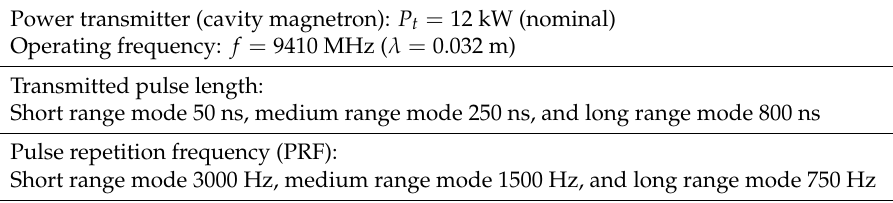
Table 1. Main parameters of the Navico / Simrad SRT radar.